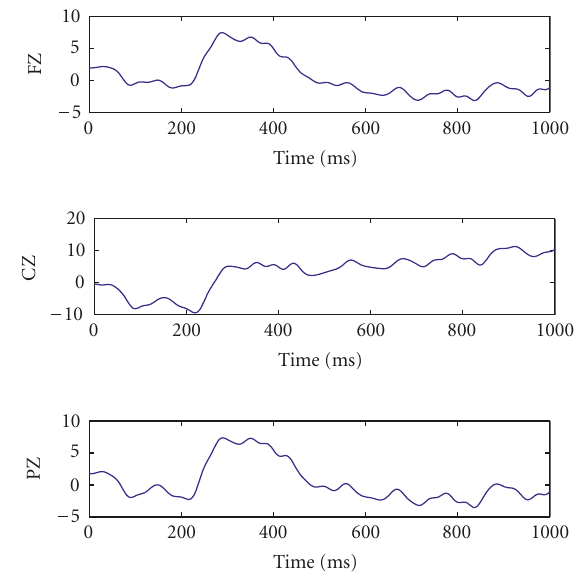
Figure 7: Three channel ERP of a schizophrenic patient obtained by averaging 40 related